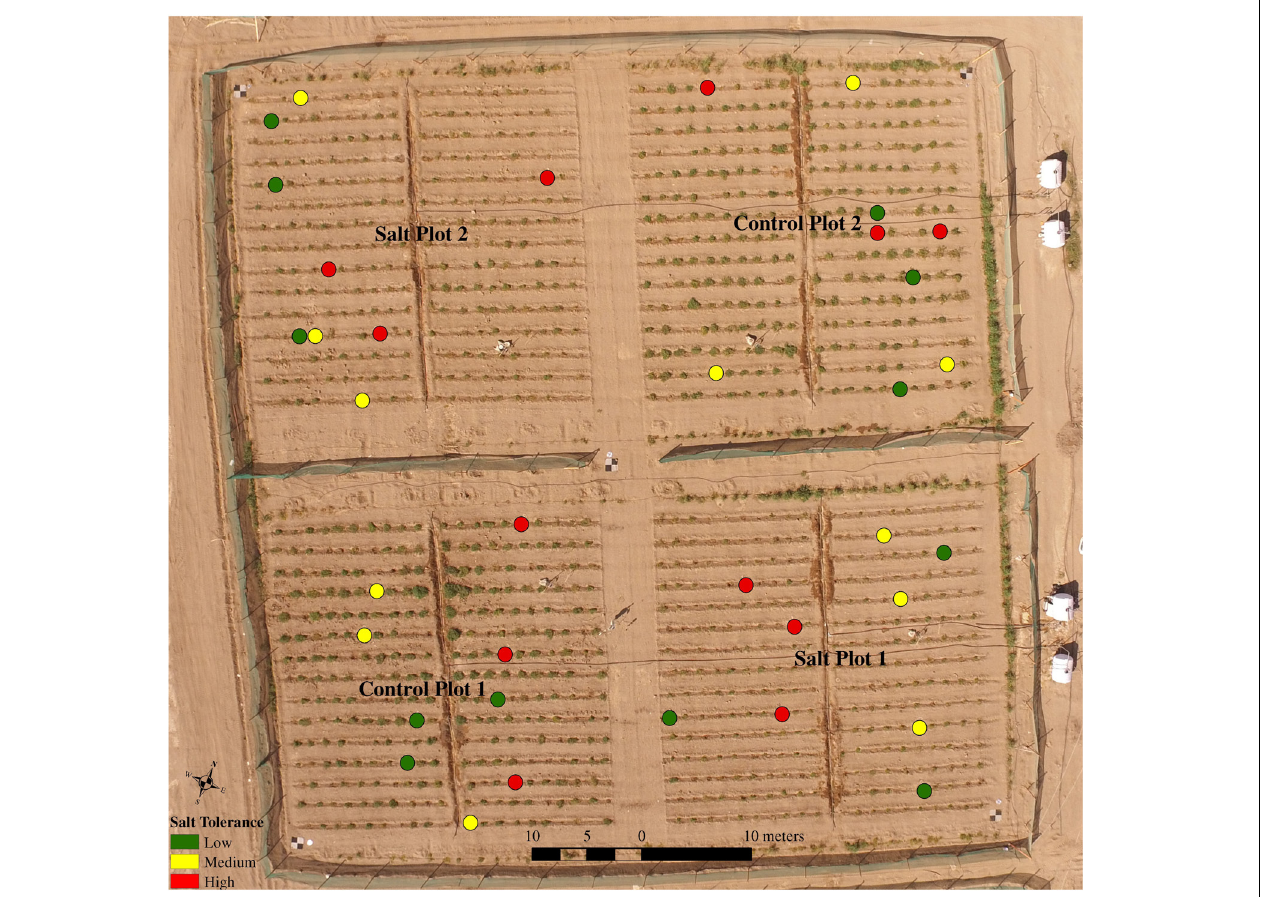
FIGURE 1 | Overview of study site at King Abdulaziz University Agricultural Research Station in Hada Al-Sham on the January 14, 2018, showing the four plots and four water tanks for irrigation as well as 36 plants with low, medium and high salt tolerance selected for focused field analysis.